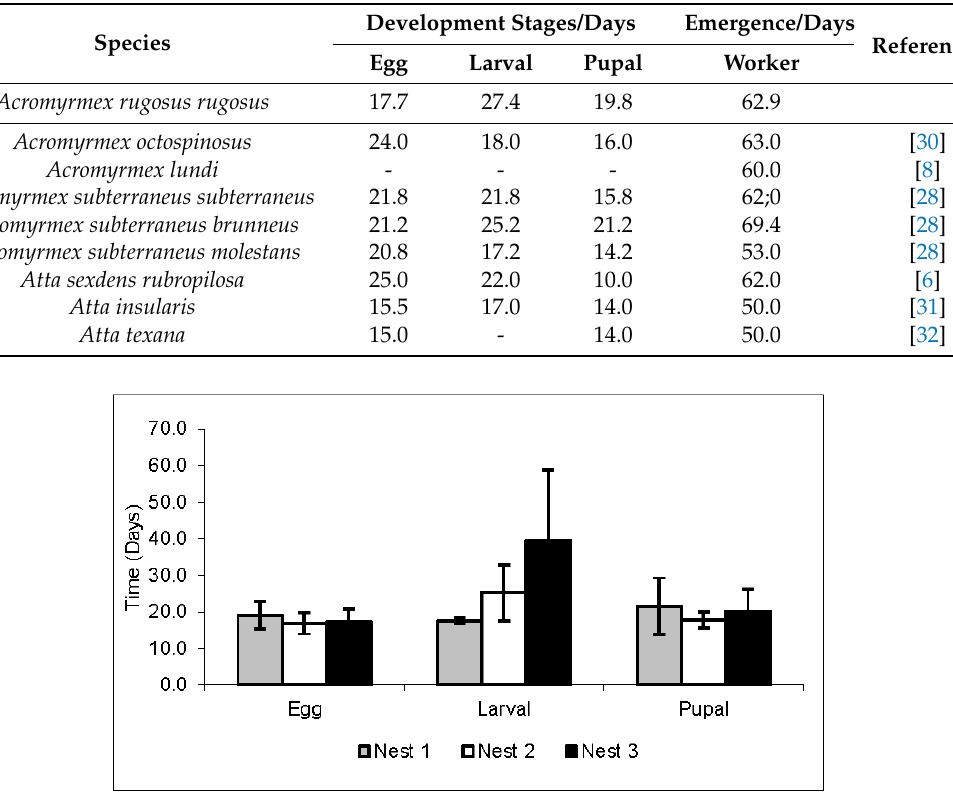
Figure 3. Stages. Mean and standard deviation of the duration time (days) of egg, larval, and pupal phases of Acromyrmex rugosus rugosus workers in three nests. Temperature: 24 °C.